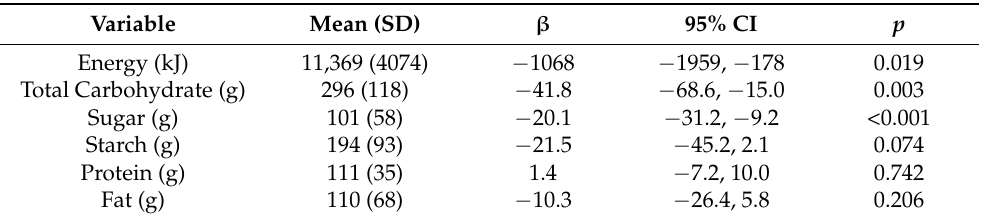
Table 4. Mean intakes of habitual energy and macronutrients as reported by the 24-h dietary records and their associations with carbohydrate taste detection